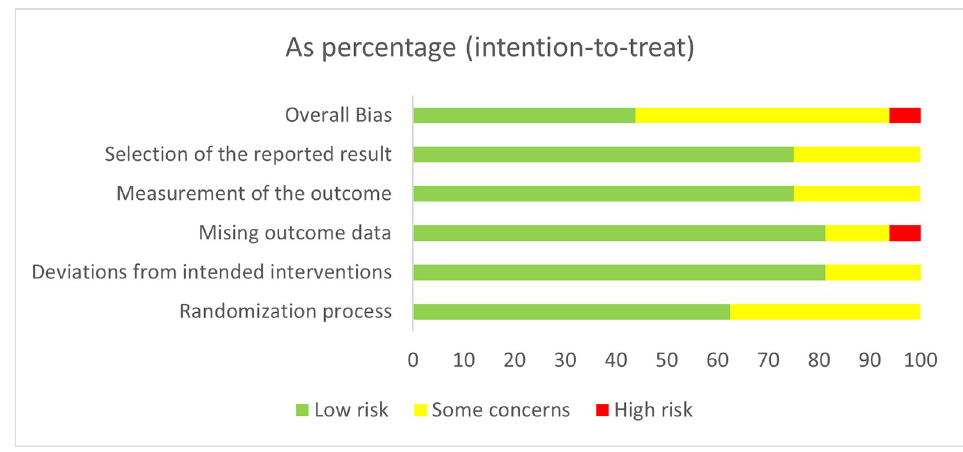
Fig 2. RoB 2 assessment of risk of bias in RCTs.